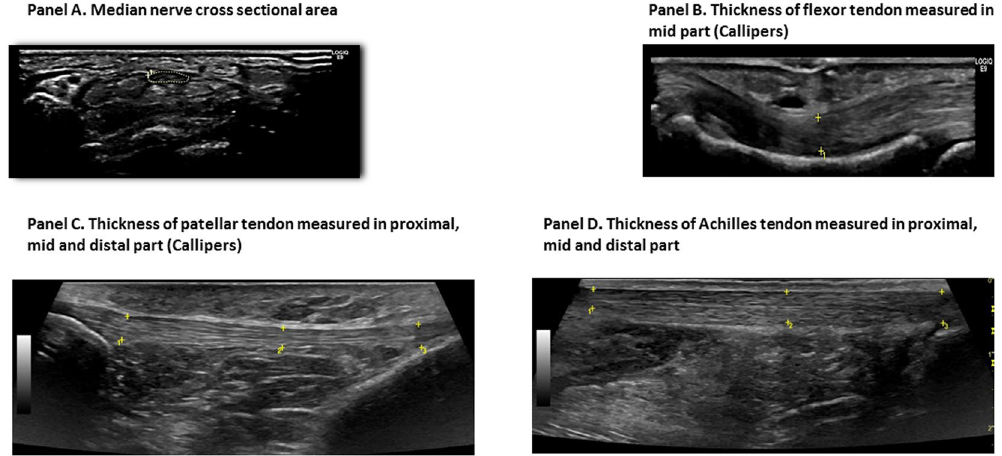
Figure 2. An overview divided in Panels (A–D) of the measurements of the median nerve cross sectional area and of tendon thickness, using the high-end sonographic